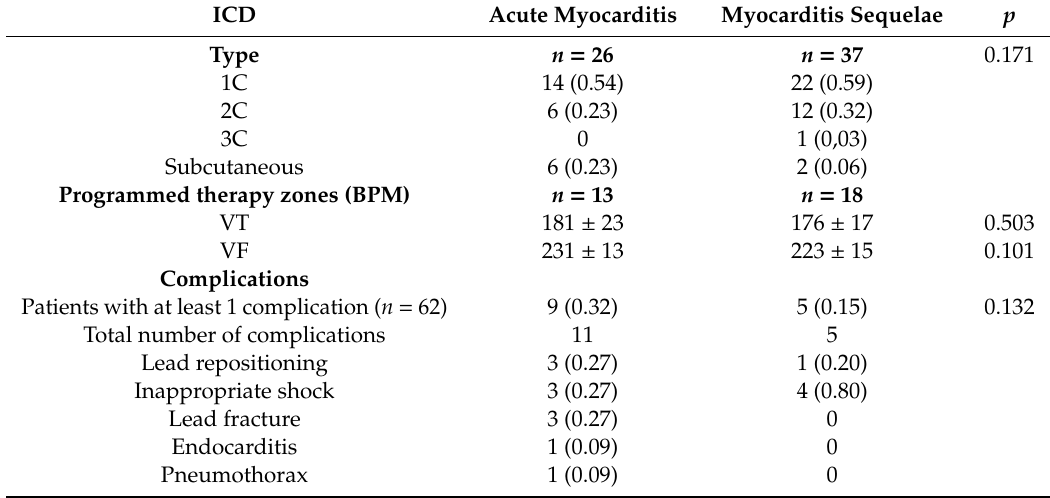
Table 5. Type of defibrillator implanted with ventricular tachycardia / fibrillation (VT / VF) zones and their complications BPM: beats per minute; ICD: implantable cardioverter defibrillator. 1C: single